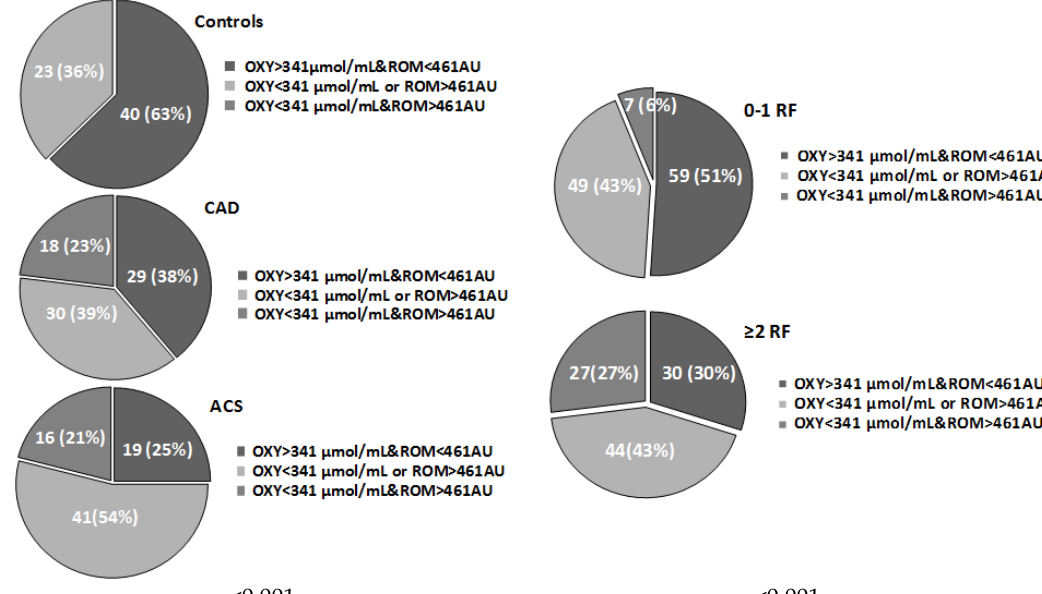
Figure 3. Number (percentage) of patients according to oxidative stress categories in control (CON), coronary artery disease (CAD) and acute coronary syndromes (ACS) group, and number of risk factors (Determinants included are type 2 diabetes (T2D), hypercholesterolemia, hypertension, smoking habits).